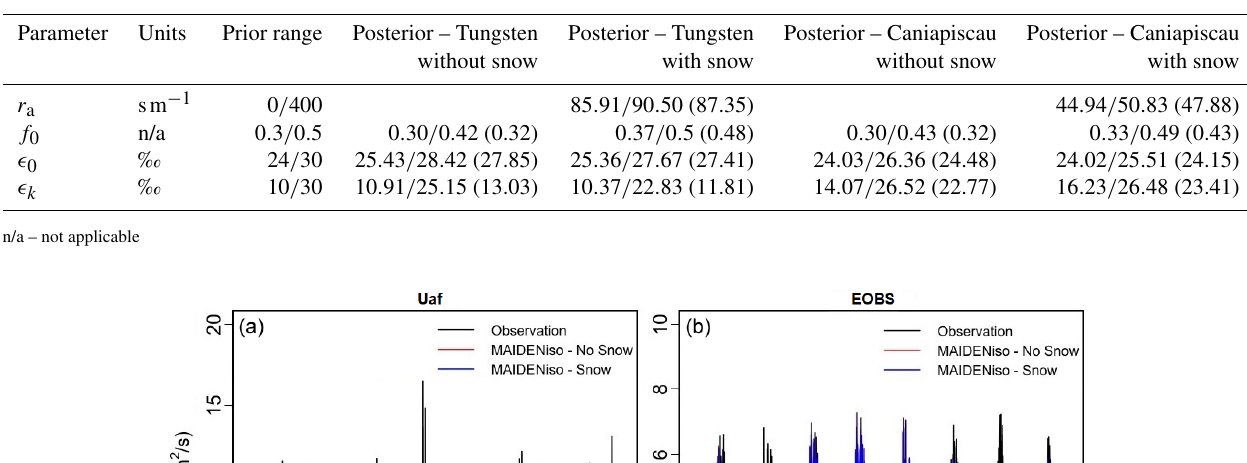
Table 4. Calibration parameters for the snow pile (for the version with snow exclusively) and δ 18 O TRC . Parameters, units, prior range, and posterior range (with parameter value in the plausible block) for both MAIDENiso versions and both sites.